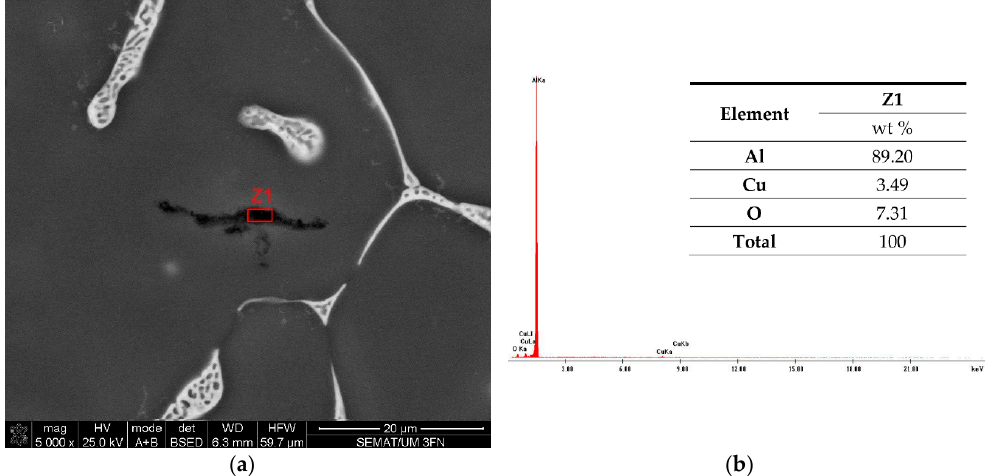
Figure 10. ( a ) Fe trace which appeared in few limited points in the second phase, batch 45U. ( b ) EDS quantification of the point in ( a ).